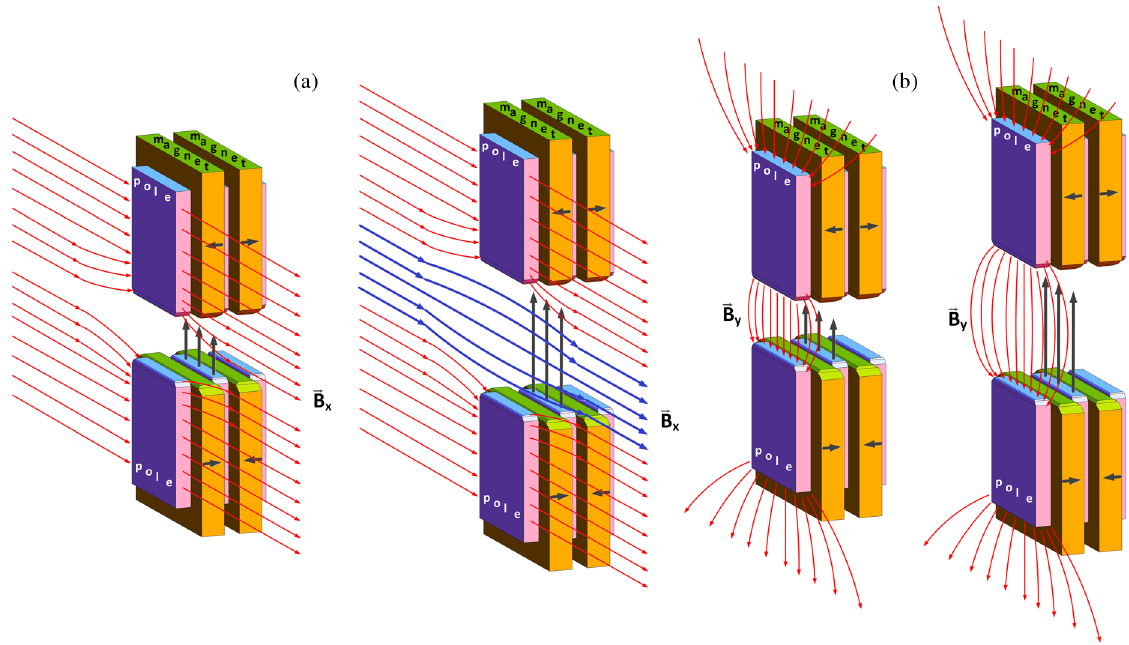
FIG. 16. External field propagation in an ID ’ s gap: (a) horizontal case; (b) vertical